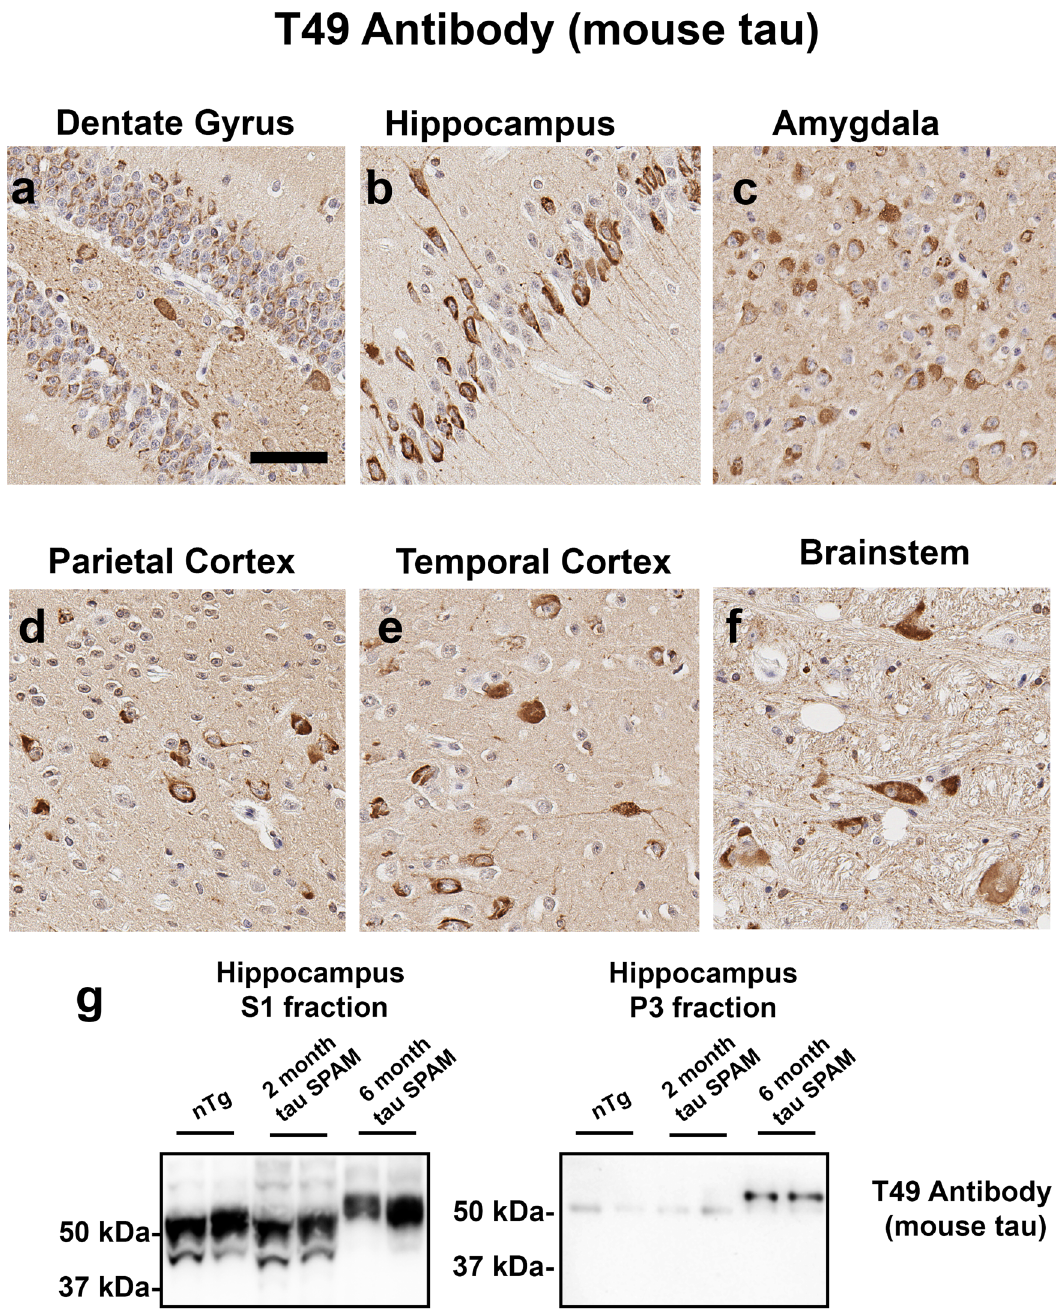
Fig. 6 Mouse tau is recruited into neuronal inclusions of tau SPAM mice. IHC with antibody T49 speci fi c for mouse tau strongly reveals NFT-like tau inclusions in ( a ) the dentate gyrus, ( b ) hippocampus, ( c ) amygdala, ( d ) parietal cortex, ( e ) temporal cortex, and ( f ) brainstem of 6-month-old tau SPAM mice. Scale bar = 100 μ m. ( g ) Biochemical fraction followed by immunoblotting with T49 antibody reveals the temporal accumulation of aggregated, hyperphosphorylated (as re fl ected by the shift in reduced mobility) mouse tau in the hippocampus of tau SPAM mice. The relative molecular mass markers are shown on the